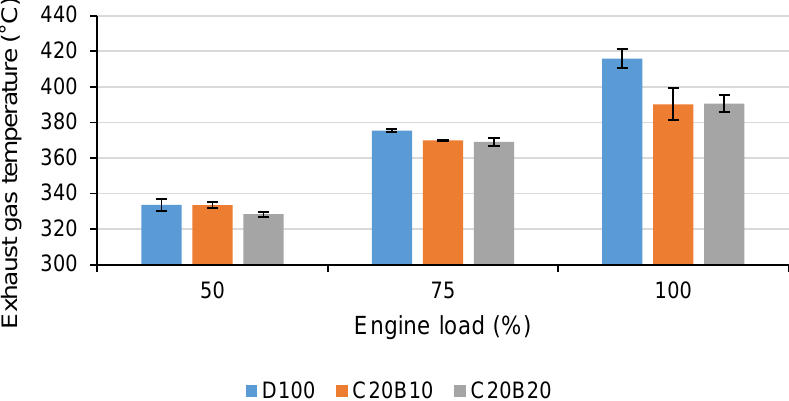
Figure 6. Exhaust gas temperature in relation to engine load for all tested fuels (error bars represent the standard deviation).